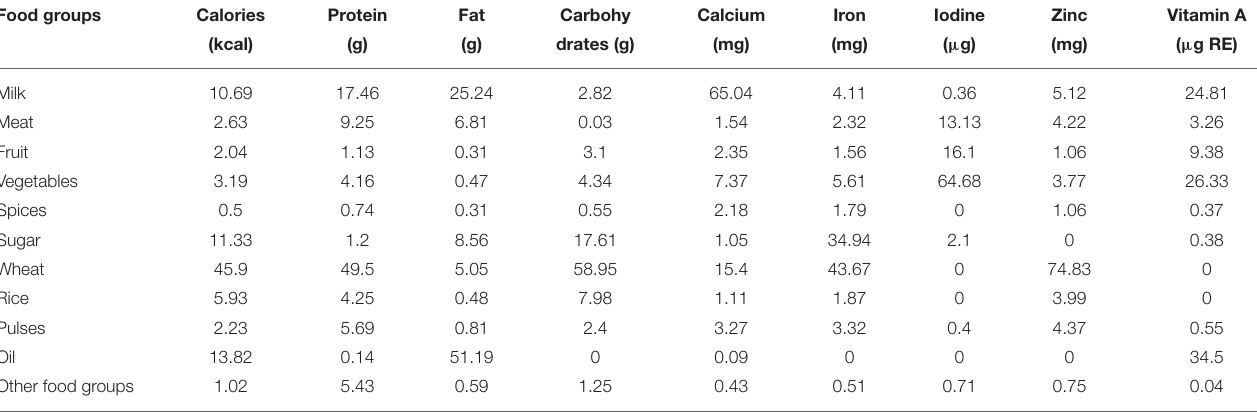
TABLE 4 | Percentage share of calories and nutrients in food groups.